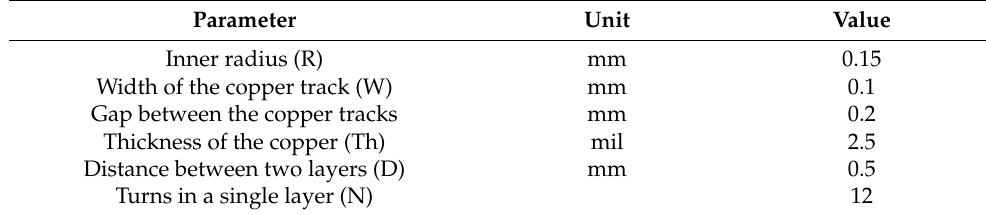
Table 1. The structural parameters of the proposed Printed Circuit Board (PCB) inductor. Parameter Unit Value